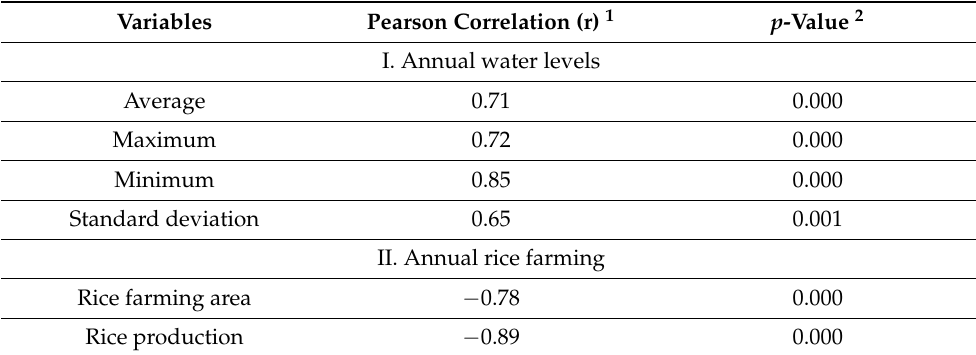
Figure 8. Trends in annual fish yield, rice farming area and rice production over a 20-year period in the Mekong Delta of Vietnam. Data from inland provinces only. Table 3. Relationships between annual fish yield and other variables.